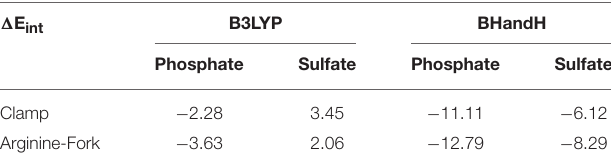
TABLE 1 | Energy values of Gibbs free energy of interaction in kcal mol − 1 . 1 E int B3LYP BHandH Phosphate Sulfate Phosphate Sulfate Clamp − 2.28 3.45 − 11.11 − 6.12 Arginine-Fork − 3.63 2.06 −